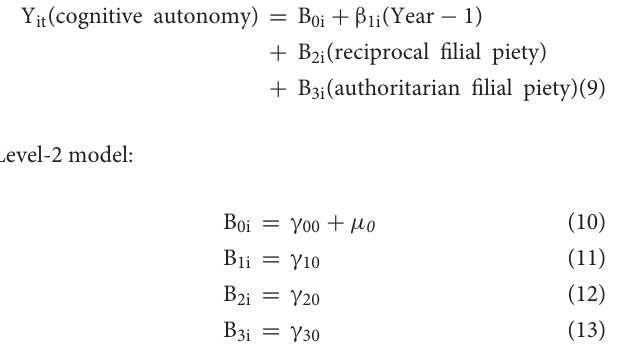
facilitative effect of AFP on depressive symptoms by intensifying adolescents’ academic